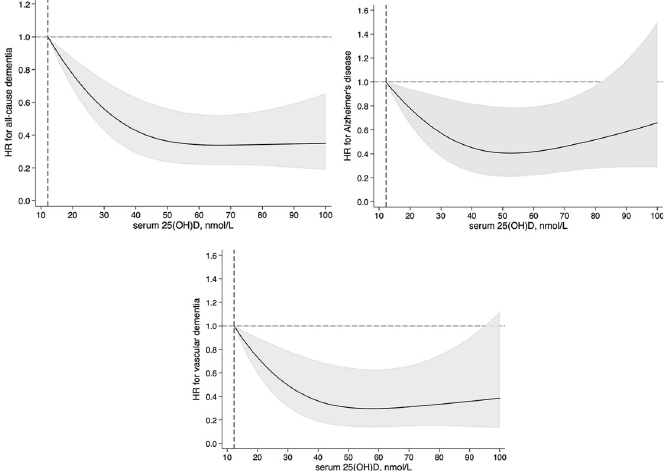
Fig 1. Multivariable adjusted hazard ratios (HRs) for risks of all-cause dementia, Alzheimer disease, and vascular dementia according to serum 25-hydroxyvitamin D (25[OH]D) level (nmol/L) among patients with type 2 diabetes ( � 60 years old). HRs were adjusted for age at recruitment (years, continuous); sex (male, female); education AU : InthelegendforFig 1 : IchangedtheeducationcategoriestomatchthosegiveninTable 1 : Ifthisisnotcorrect ; pleaseeditasnecessary : (college or university degree, A/AS levels or equivalent or O levels/General Certificate of Secondary Education or Certificate of Secondary Education or equivalent, National Vocational Qualification or Higher National Diploma or Higher National Certificate or equivalent or other professional qualifications, none of the above); Townsend deprivation index (continuous); ethnicity (White, Mixed, Asian, Black); blood collection season (Dec–Feb, Mar–May, Jun–Aug, Sep–Nov); sun-exposure time in summer (hours/day, continuous); APOE ε 4 (carrier, non-carrier); BMI (kg/ m 2 , continuous); alcohol intake (never or special occasions, monthly to weekly, daily); smoking status (never, past, current); physical activity (MET-hours/week, continuous); healthy diet score ( � 3, > 3); sleep duration ( � 6, 7–8, � 9 hours/day); multivitamin supplements (yes, no); diabetes duration (years, continuous); concentration of HbA1c (mmol/mol, continuous); medication for diabetes (none, only oral medicine, insulin and others); history of hypertension, cardiovascular disease, cancer, and depression (yes, no); medication for hypertension and cholesterol (yes, no); circulating total cholesterol (mmol/L, continuous); triglycerides (mmol/L, continuous); low-density lipoprotein cholesterol (mmol/L, continuous); and C-reactive protein (mg/L, continuous). Values beyond the 1th and 99th percentile of serum 25(OH)D were winsorized to minimize the potential impact of extreme values. P nonlinearity < 0.001 for all-cause mortality, P nonlinearity = 0.06 for Alzheimer disease, and P nonlinearity = 0.007 for vascular dementia. Black curves are HRs, and grey zones are 95% CIs.